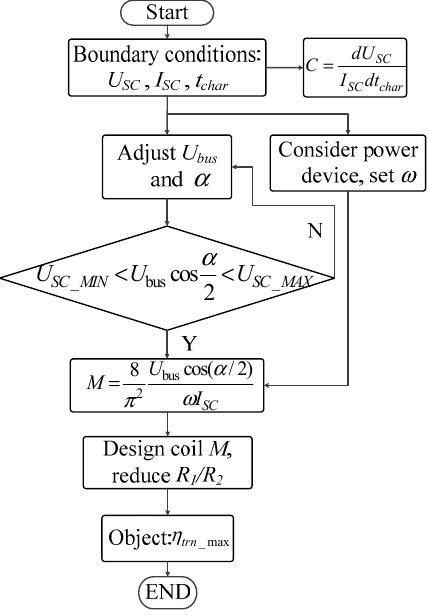
Figure 11. Design process.